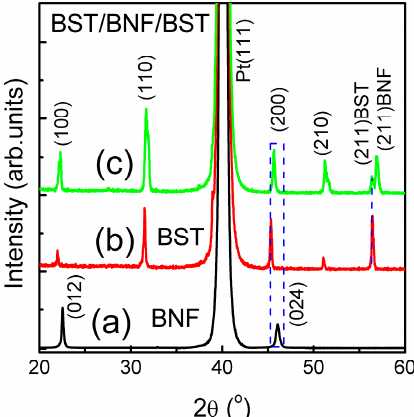
Figure 1. XRD patterns of ( a ) BNF, ( b ) BST, and ( c ) BST/BNF/BST thin films on Pt(111)/Ti/SiO 2 /Si(100) substrates. When BST and BNF thin films sputter, the maintenance of 500 °C is the ideal substrate temperature, and Ar/O 2 (pressure ratio 9:1) and nitrogen are the ideal deposition atmosphere, respectively. We annealed the samples at 650 °C by use of a rapid thermal annealing (RTA) furnace.